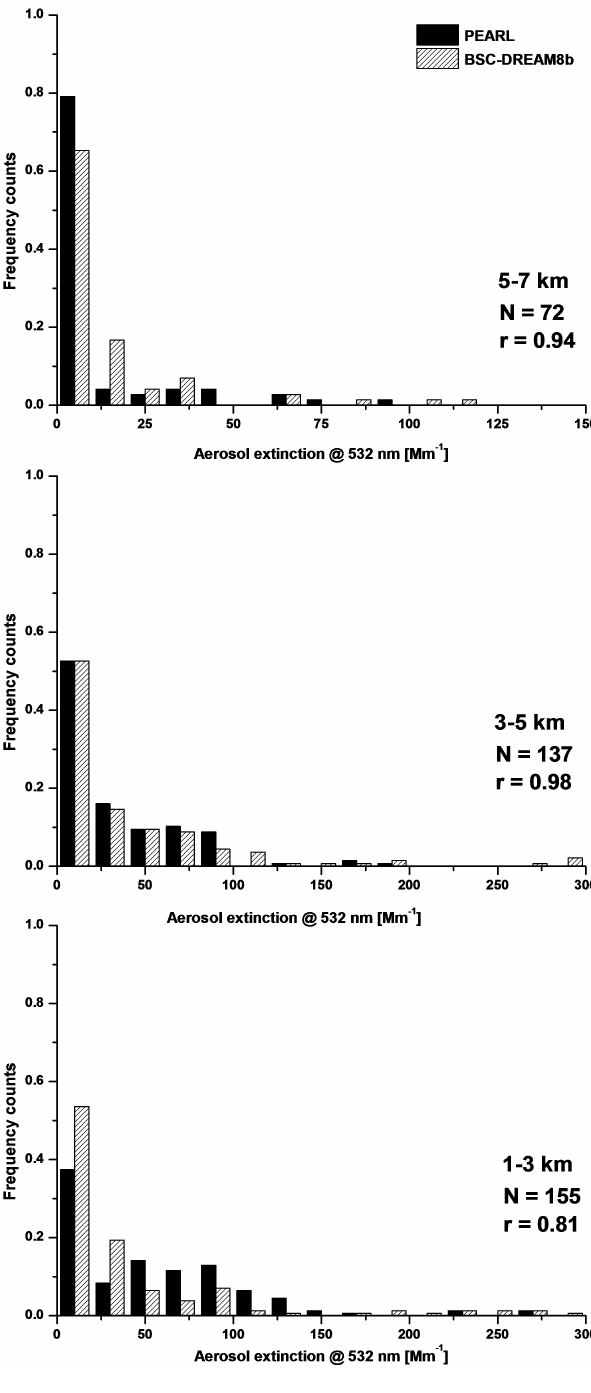
Figure 4. Distributions of aerosol extinction values reported at 532nm inside dust layers by PEARL measurements and BSC- DREAM8b model. The distributions correspond to three different height classes: 1–3kma.s.l. (bottom panel), 3–5km (middle panel) and 5–7kma.s.l. (top panel).